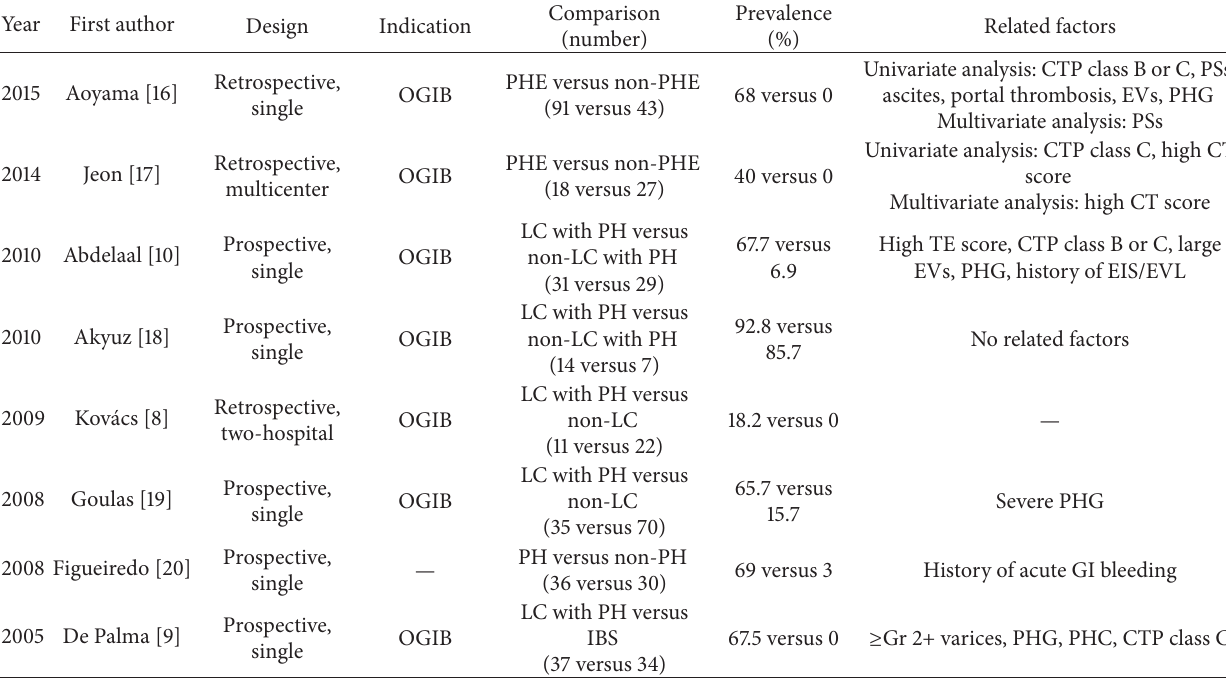
Table 2: Prevalence of and factors related to portal hypertensive enteropathy using capsule